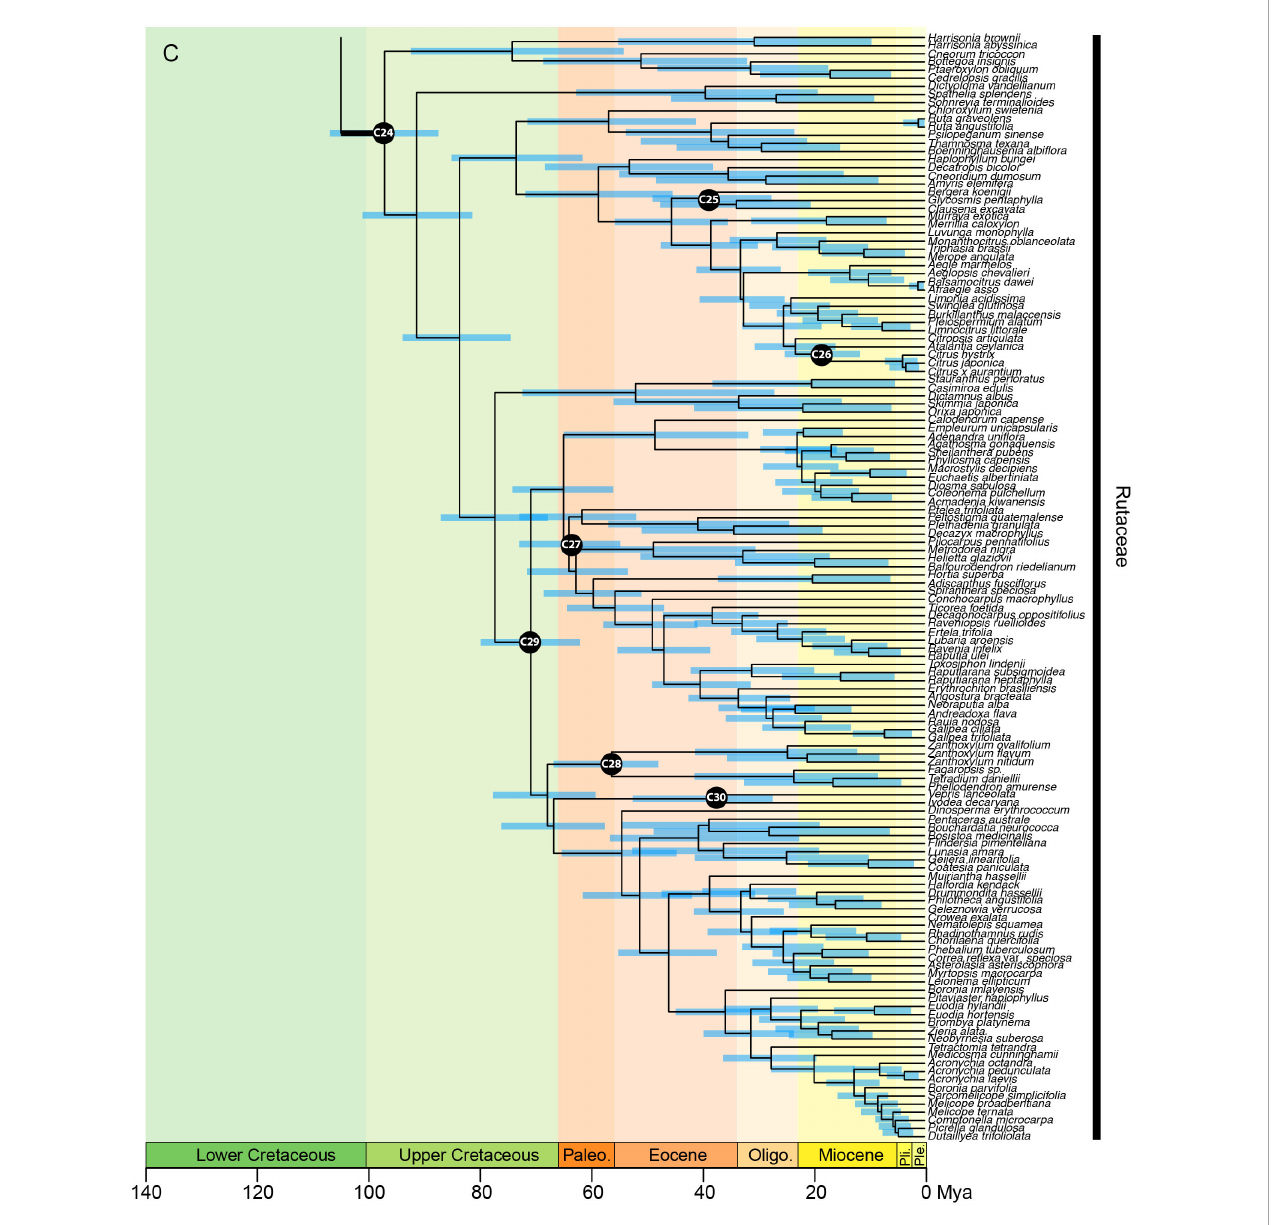
FIGURE 4C Chronogram of Sapindales as estimated under a relaxed-clock model with a normal secondary root prior distribution (node C01) and uniform primary calibrations. Tree topology was fi xed to the concatenated tree (see Figure 2). (A) shows Nitrariaceae, Biebersteiniaceae, Sapindaceae; (B) shows Kirkiaceae, Burseraceae, Anacardiaceae, Simaroubaceae, Meliaceae, and (C) shows Rutaceae. Black circles with C01-C30 signify calibrated nodes (see Table 1 for fossil information); blue bars represent 95% highest posterior densities (HPDs); thickened branches indicate stem branches of